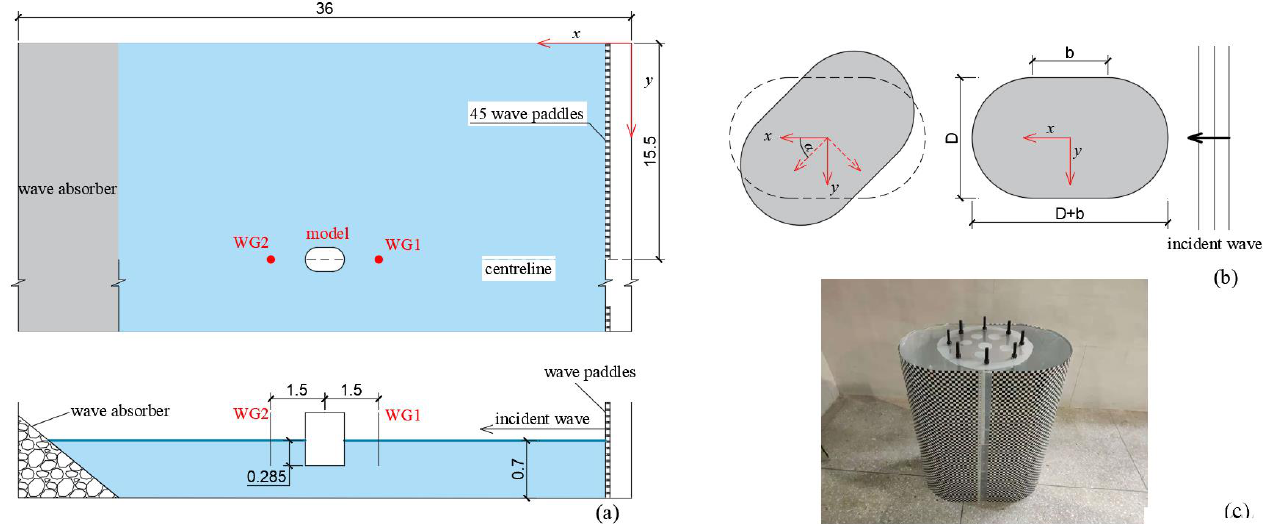
Figure 1. The testing facility: ( a ) the wave flume; ( b ) dimensions of the model; ( c ) photo of the test model. (unit: m).